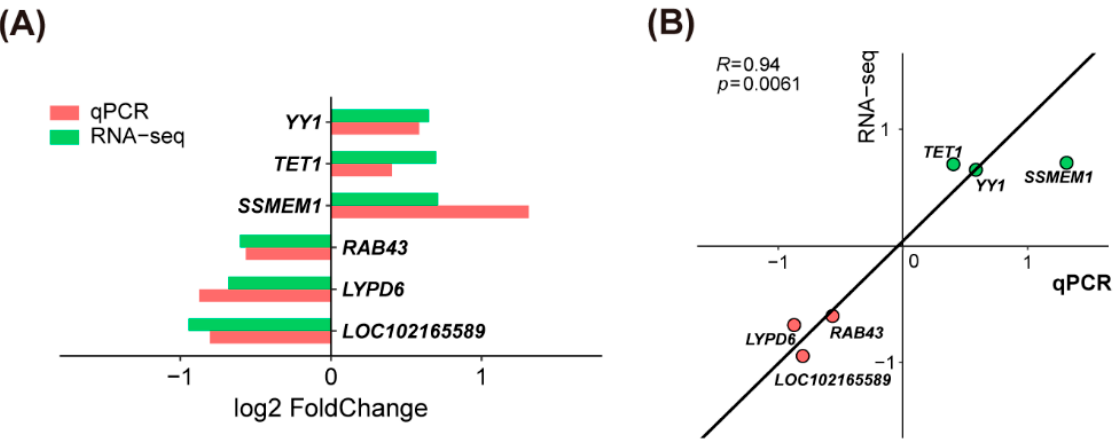
Figure 6. Verification of randomly selected RNA-seq-identified DEGs by